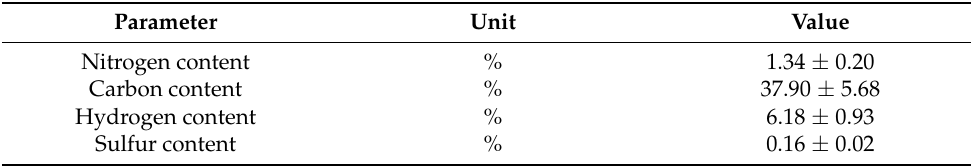
Table 9. Results of the elemental analysis of beet pulp.